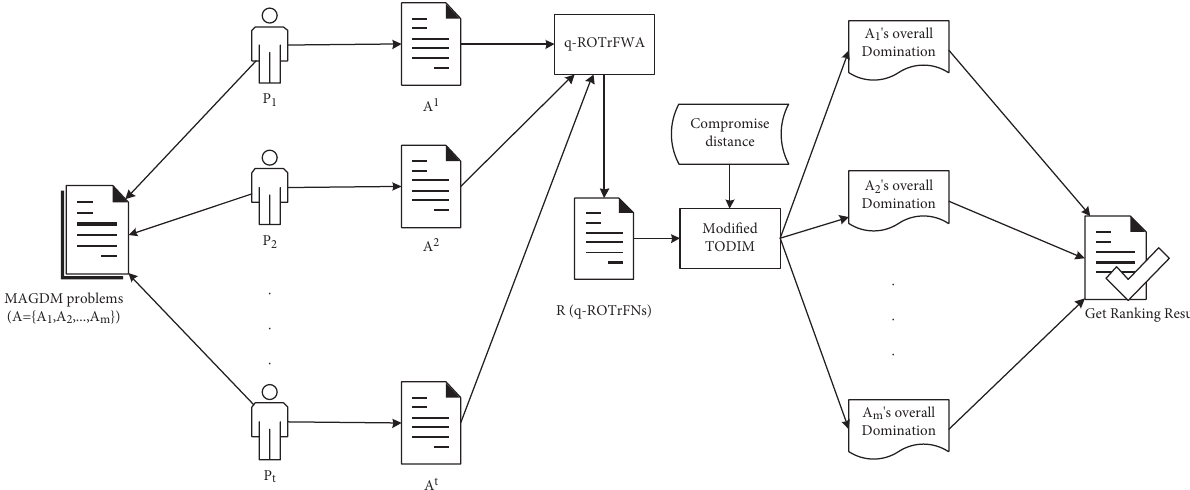
Figure 4: The process of the group method with q -ROTrFNs. Table 1: Evaluation value matrix by expert